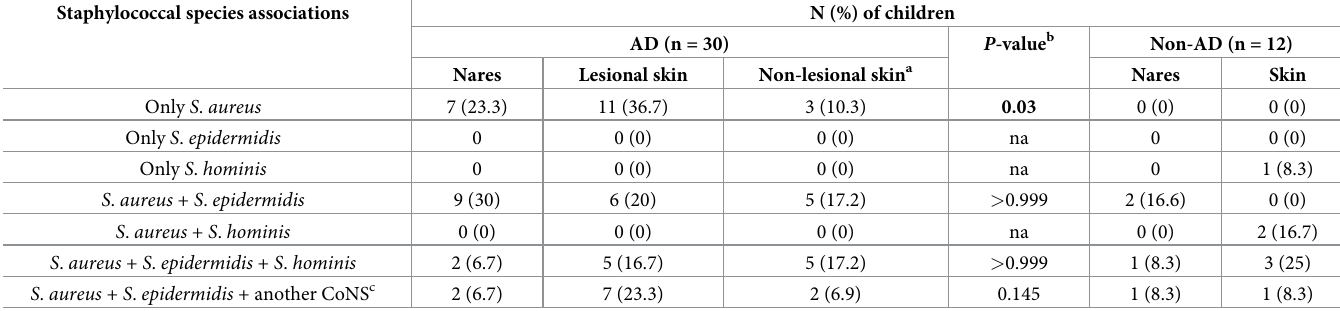
mg/L, respectively. All isolates were sensitive to mupirocin and clindamycin. Five (5.2%) iso- detected in the AD group, colonizing three children. One hundred eighty CoNS isolates were evaluated for methicillin susceptibility (120 from the AD group and 60 from the non-AD children), mainly S . epidermidis (46.1%) and S . homi- and non-AD groups, with more than 20% of isolates per species being resistant to methicillin Table 2. Major staphylococcal species associations identified colonizing the skin of children with and without atopic dermatitis. Staphylococcal species associations